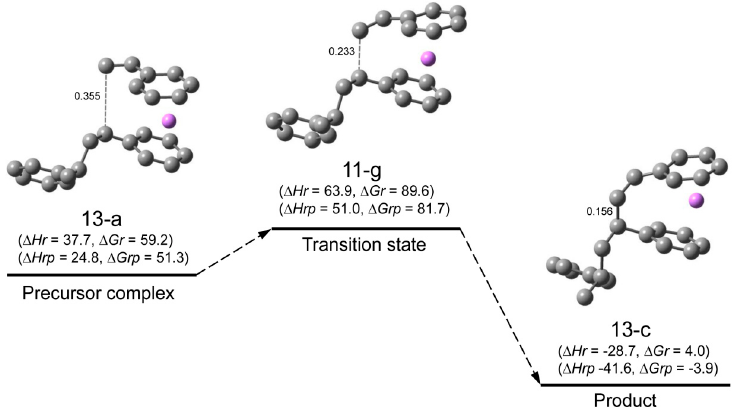
Figure 12. Reaction pathway for system(s-11-a) (St/[HSt 2 Li(10-c)]) in the gas phase. ∆ Hr and ∆ Gr , the relative enthalpy and relative free energy, are expressed in kJ·mol –1 . Hydrogen atoms are not shown. Numerical values in the drawings as in Figure 5.